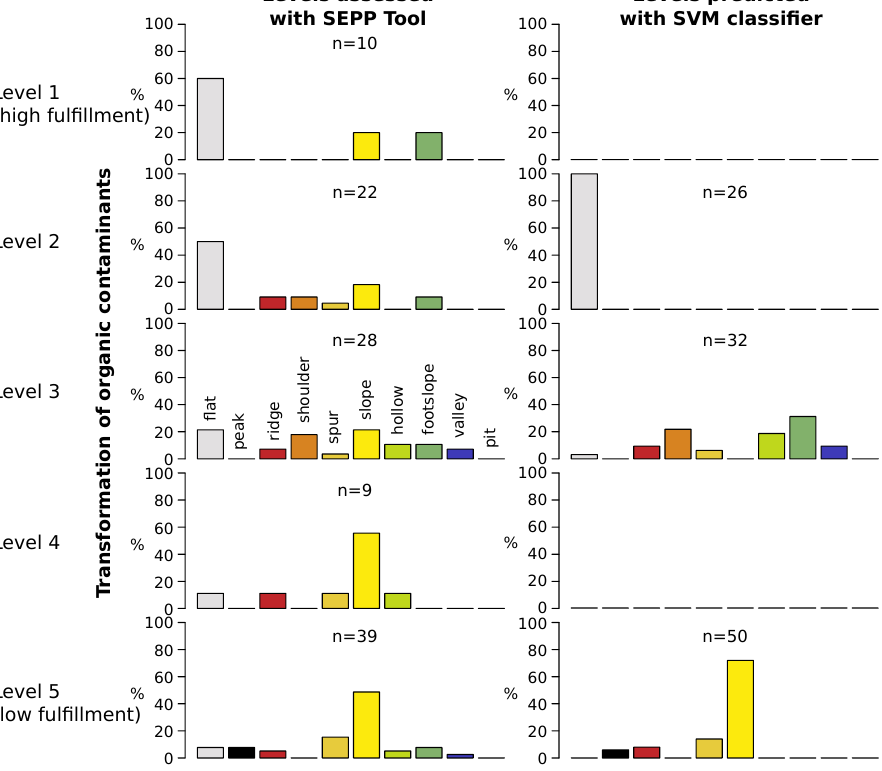
Figure 8. Barplots representing the distribution of the landform classes for the different fulfillment levels regarding the soil function of transforming organic contaminants. The left column shows the distribution of the levels as evaluated by the SEPP tool, whereas the right column shows the distribution of the levels as predicted by the SVM classifier based on landforms and maximal